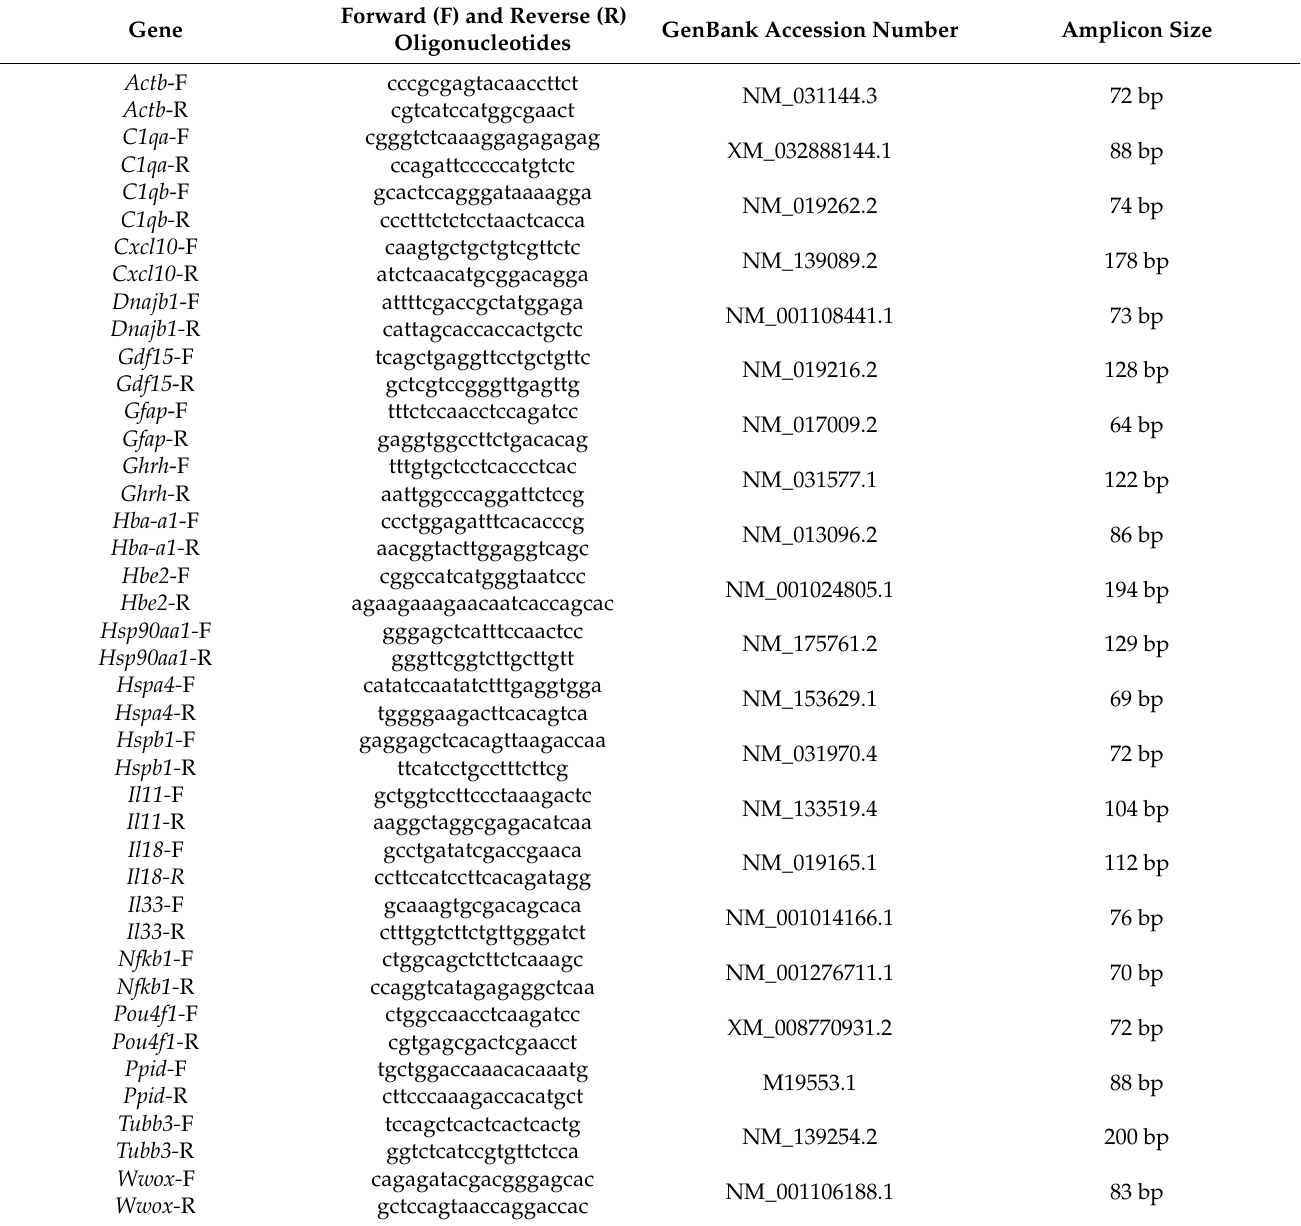
Table 1. Sequences of oligonucleotide pairs. The listed primer pairs were used in quantitative real- time PCR experiments, while Actb and Ppid served as housekeeping genes. The predicted amplicon sizes are given. F = forward, R = reverse, bp = base